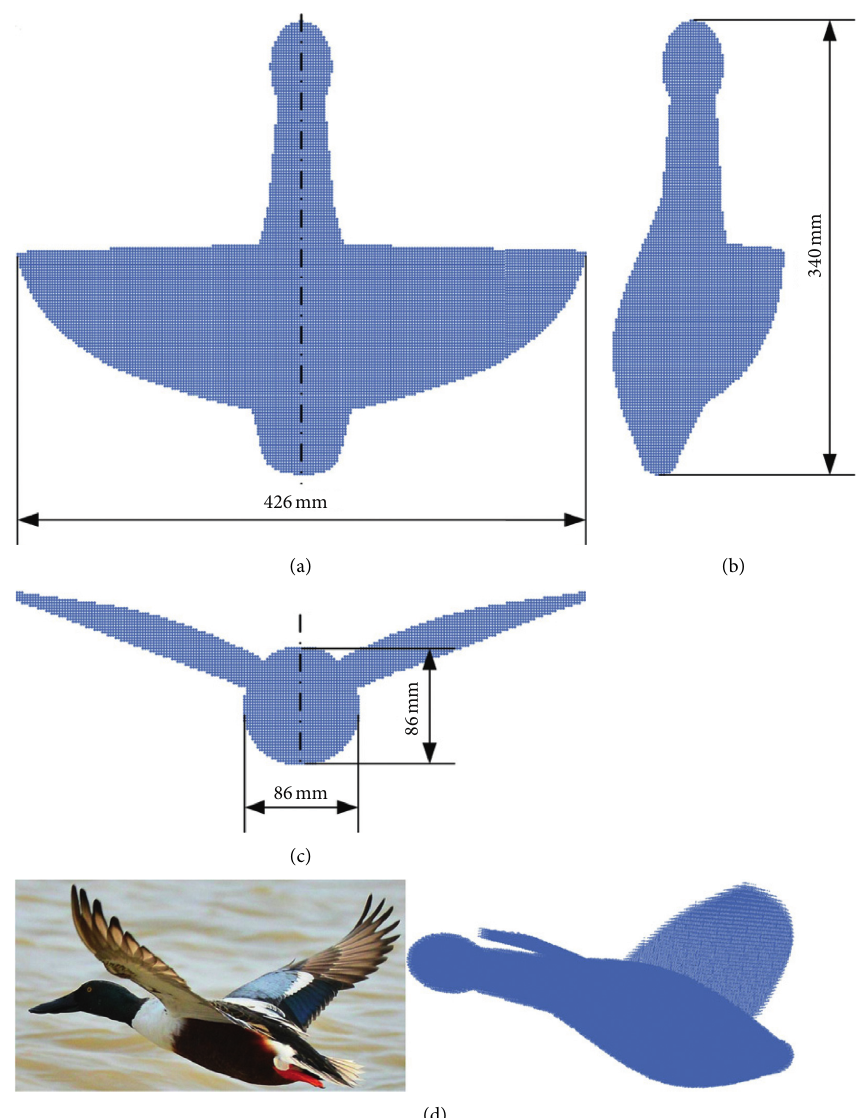
Figure 4: A realistic bird model by the SPH method. (a) Left view. (b) Front view. (c) Bottom view. (d) A real mallard compared to the SPH